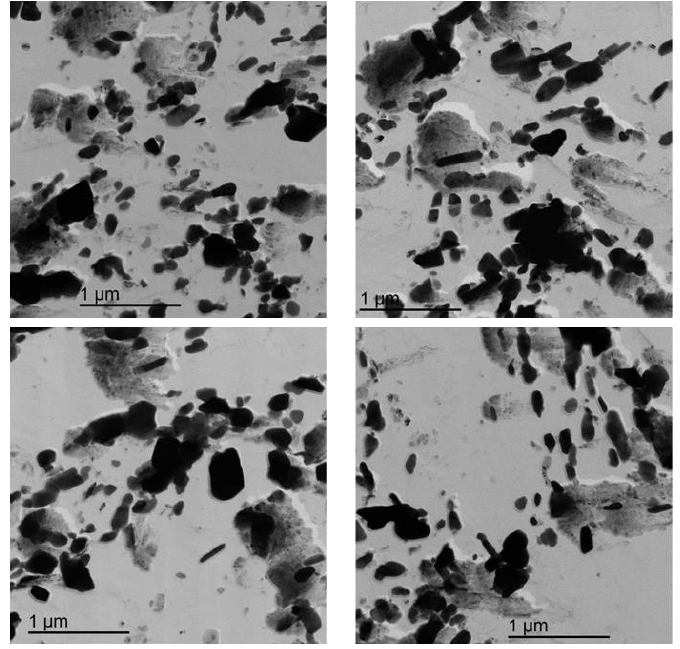
Figure 15. Exposed material specimen 92-EX-1-2 (92 BM 604 °C 43 MPa 74,001 h) (sample E), ternary diagram ( a ) and size distribution ( b ) (TEM analysis).